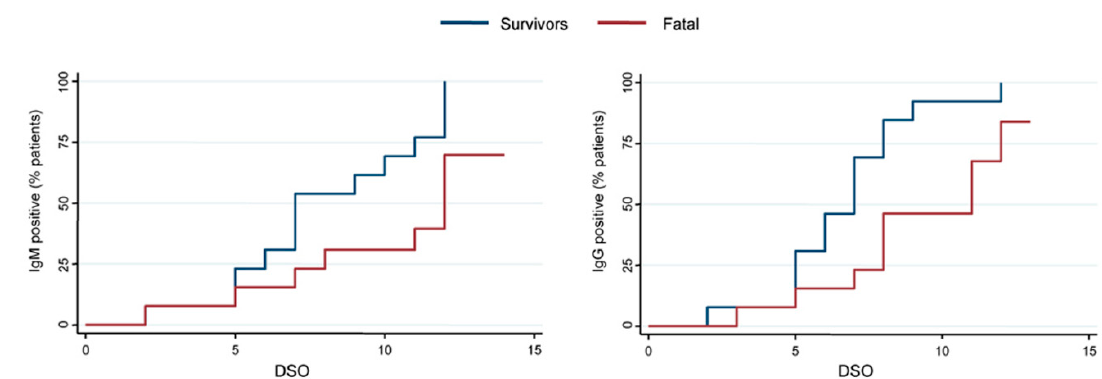
Figure 2. Kaplan–Meier curves reporting the proportion of survivor (blue line) and fatal (red line) patients developing anti-EBOV specific IgM ( left ) and IgG ( right ) in relation days from symptom onset (DSO). The proportion of patients is expressed as a percentage. Statistical significance ( p < 0.05) by Log-rank test: IgM, p = 0.0351; IgG, p = 0.0141.